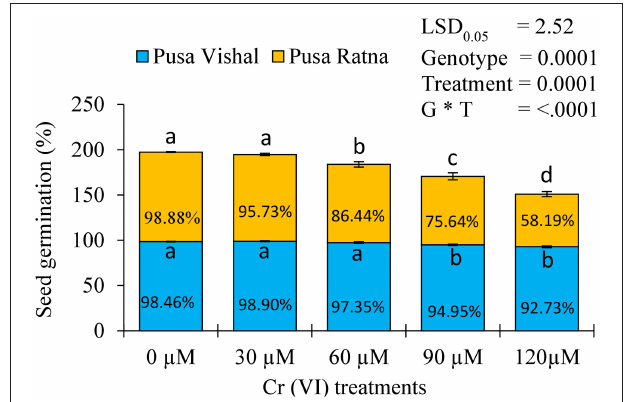
FIGURE 1 | Percent inhibition of germination in the two Mungbean cultivars under chromium (Cr [VI]) toxicity. Mean values of three replicates are shown; error bar ( ± standard error [SE]). Mean values with the same letter don’t have significant difference at p ≤ 0.05, according to the Least Significant Difference test (LSD 0.05